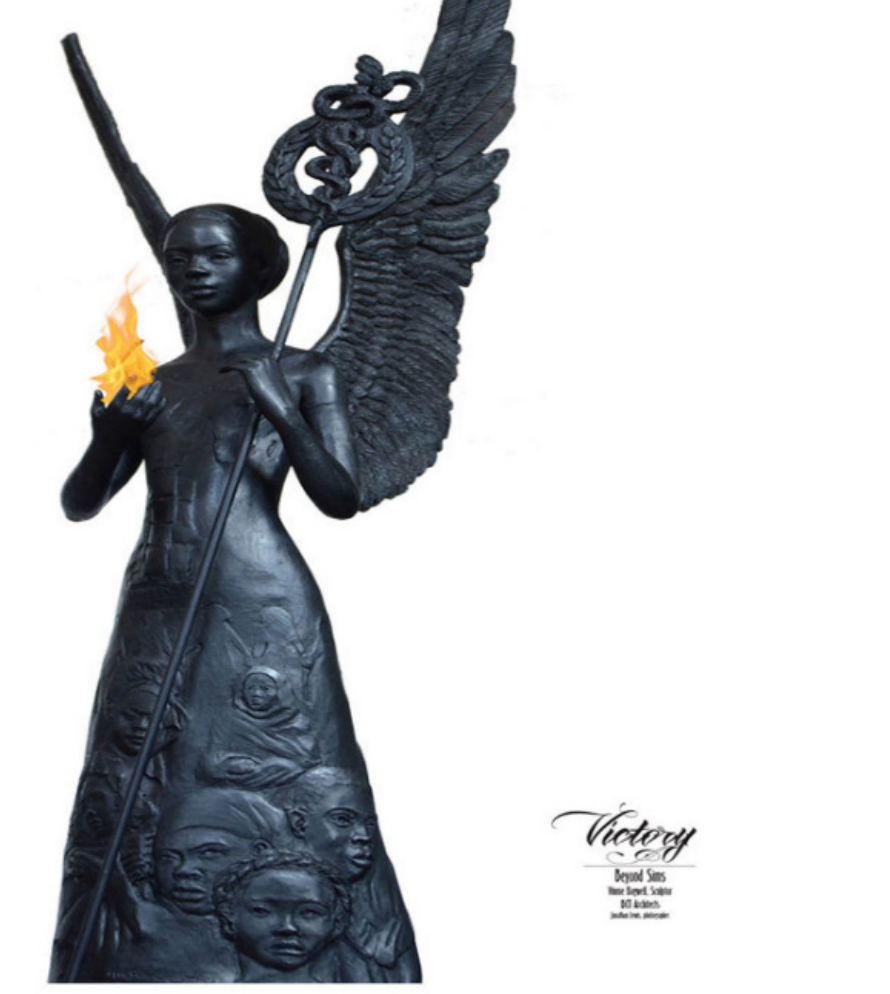
Figure 5. “Victory Beyond Sims” Rendering, by Sculpture Vinnie Bagwell Image Source: Artforum.com (accessed on 12 December